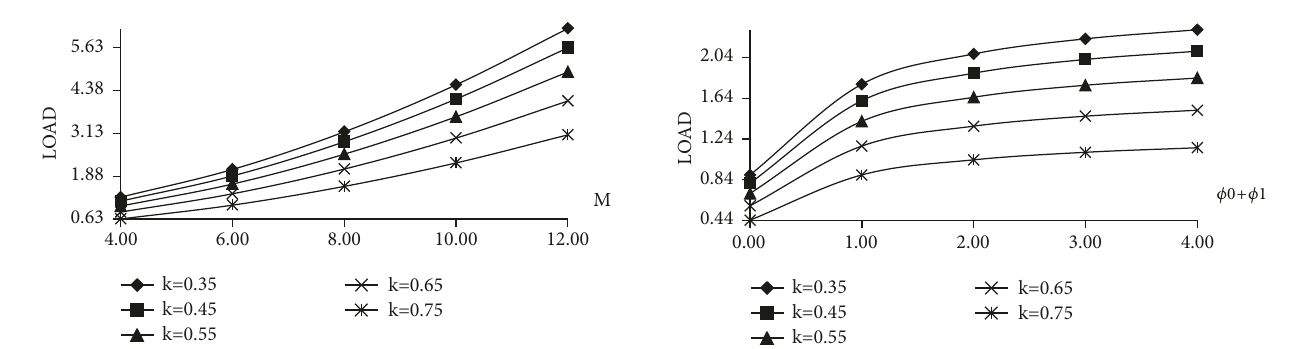
Figure 9: Distribution of load bearing capacity with respect to 𝜙 0 + 𝜙 𝜀 ∗ . 1 and